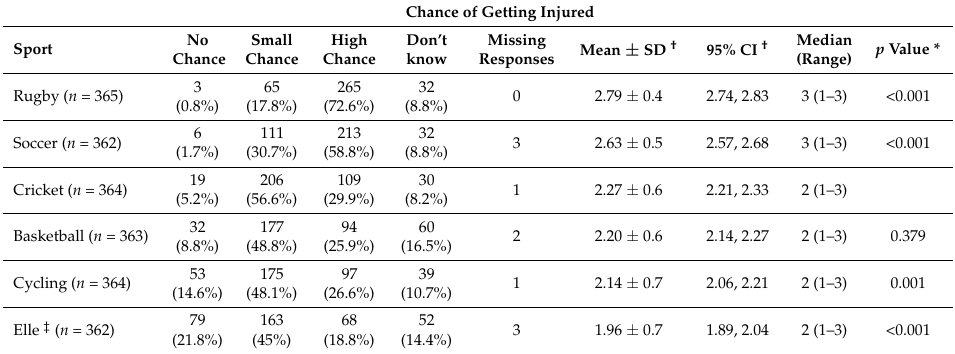
Table 2. Frequency and percentage (%) of perceived risk, a person has of getting injured among different sports, and comparison of scores with playing cricket using Wilcoxon signed rank